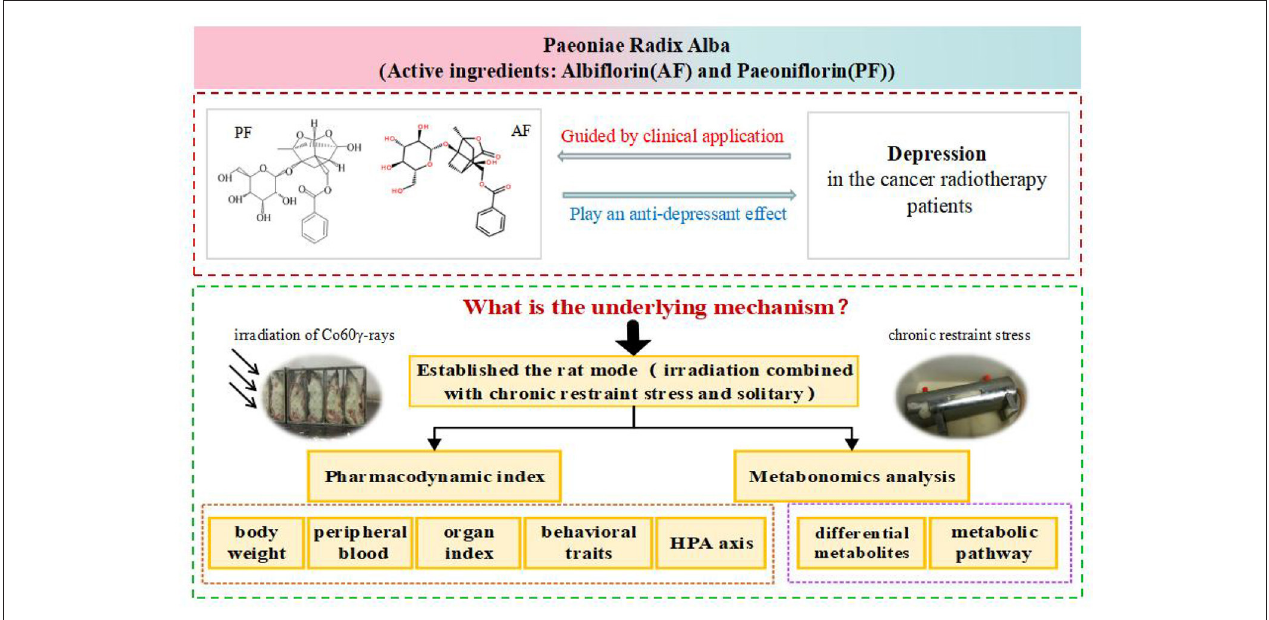
FIGURE 1 | Research outline of the